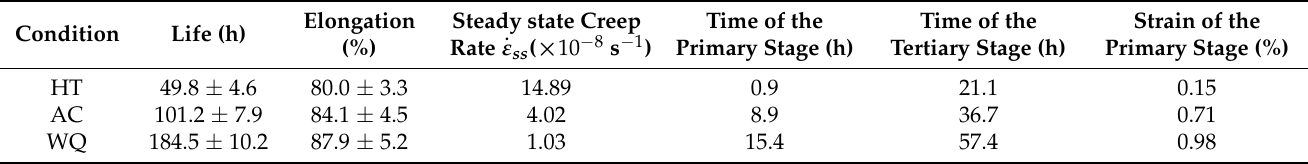
Table 5. Creep properties of the different heat treatment sample at 1100 ◦ C/137 MPa.